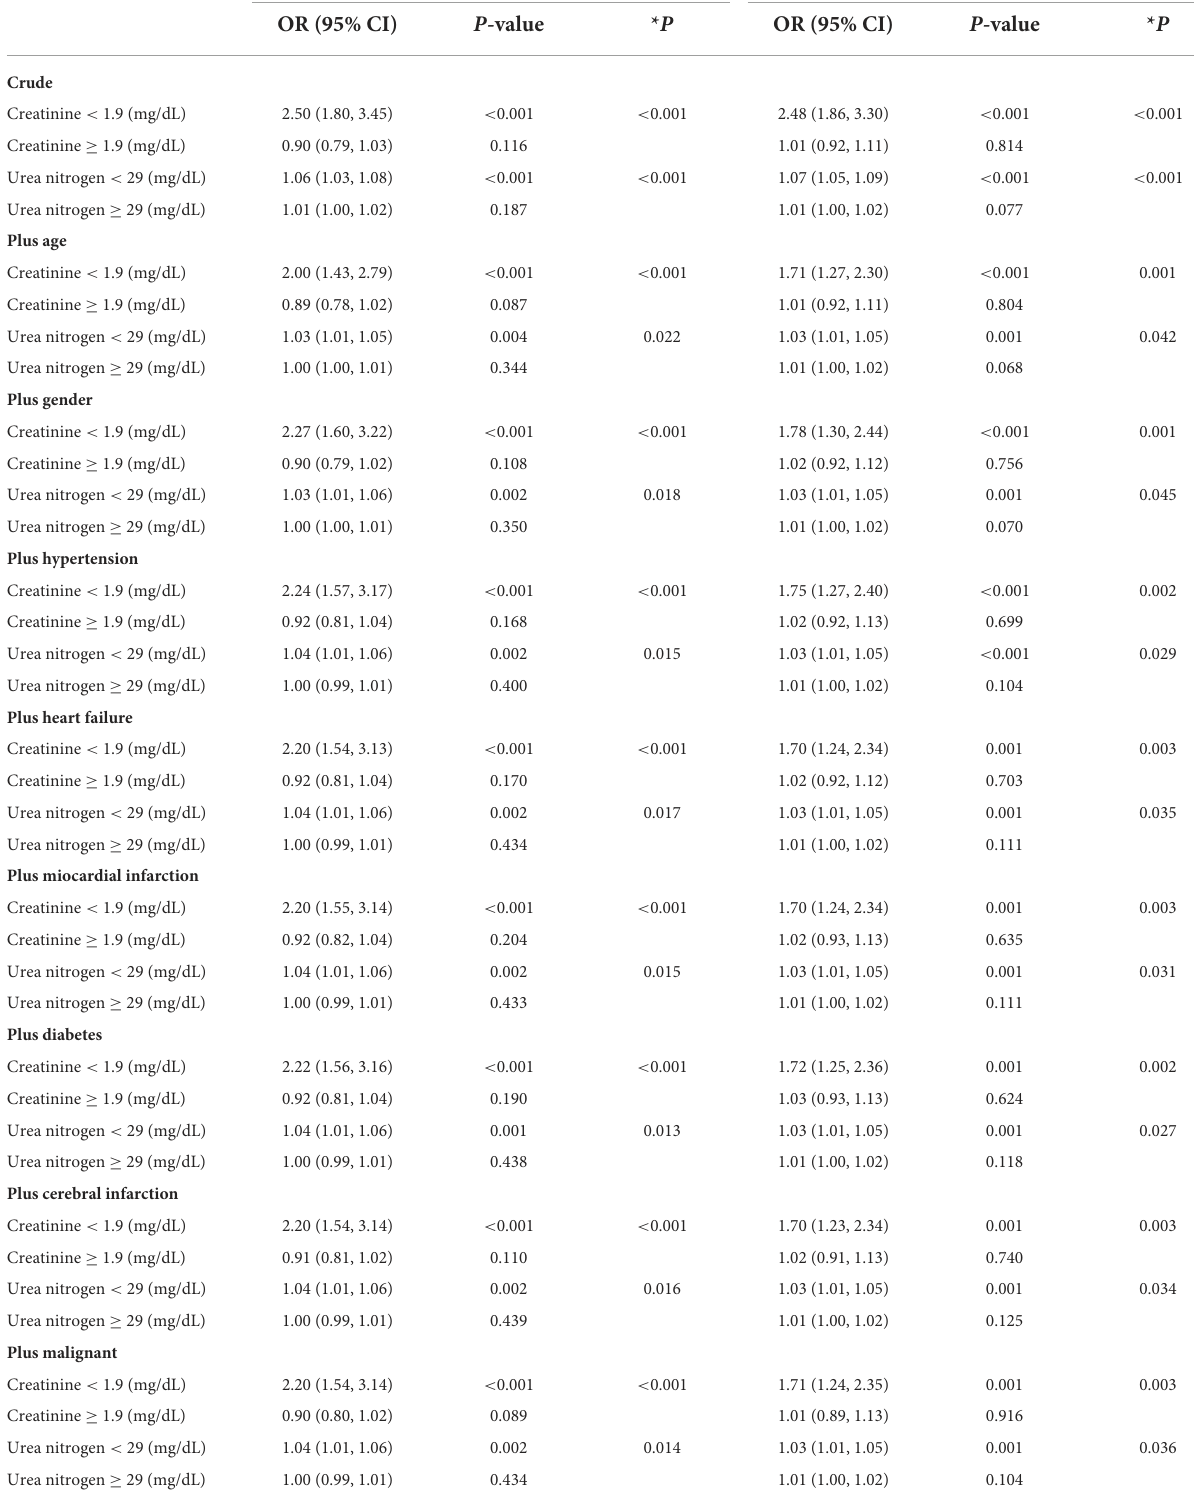
TABLE 6 Interaction analysis by “inflection point” for associations of blood creatinine and urea nitrogen with hospital mortality and 1-year mortality in ICU patients with intracranial